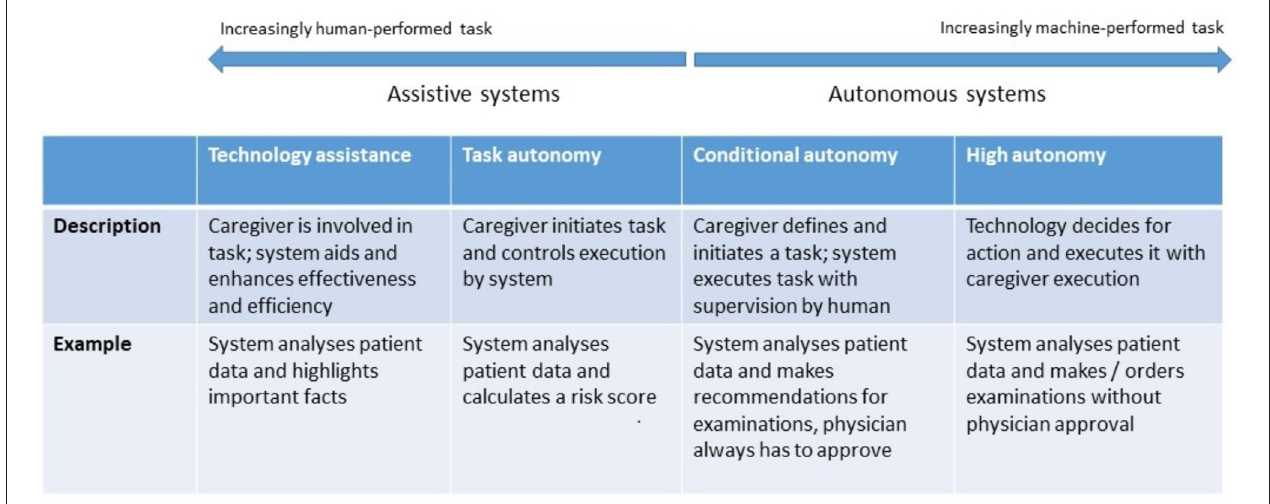
FIGURE 3 | Levels of autonomy of robotic and AI systems. [following models proposed by (16)].